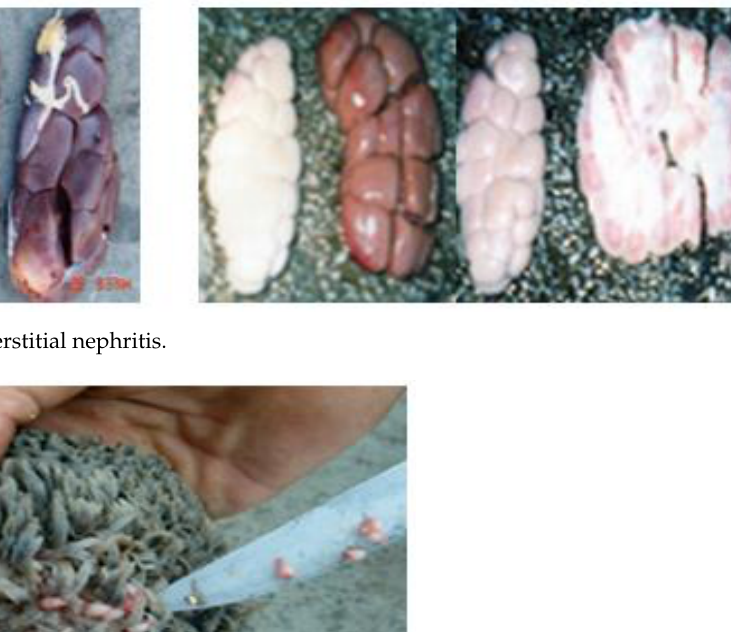
Figure 1. Focal non-purulent interstitial nephritis with whitish foci on the kidney surface ( a ) and on the cross section ( b ).